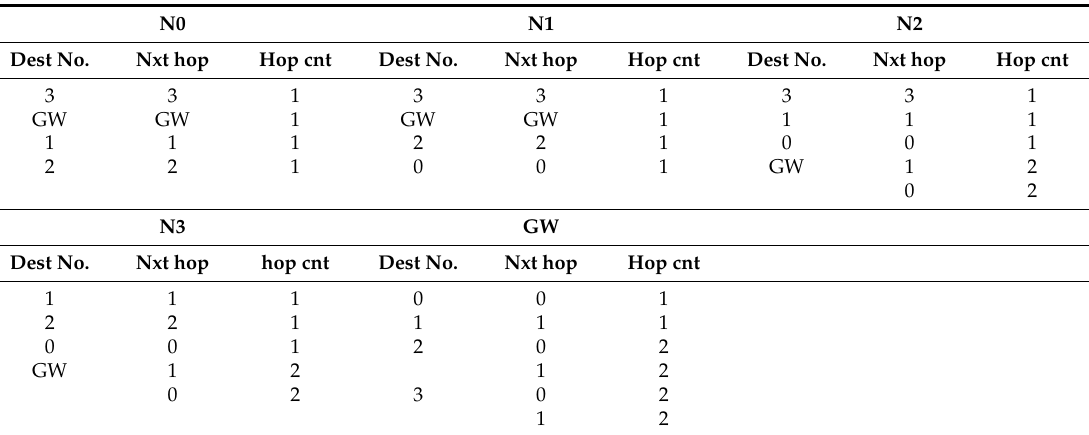
Table 1. Routing table before rain being detected at node 0.